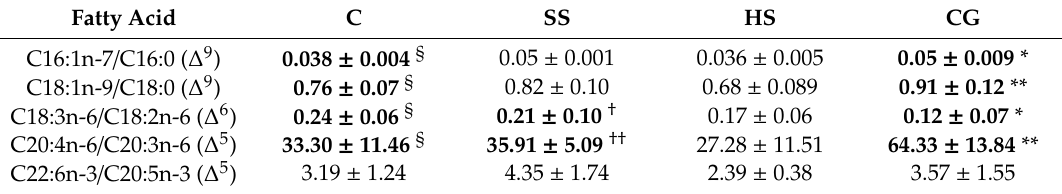
Table 7. Indirect desaturation indexes of the desaturases in the fatty acids from serum of